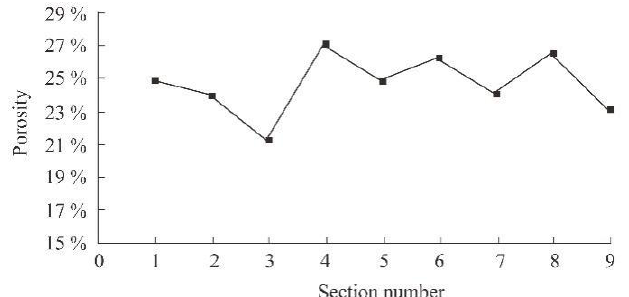
Figure 12. Distribution map of pore gradient with different diameters. ( a ) Distribution map of pore gradient in the range of 0.01–0.49 mm. ( b ) Distribution map of pore gradient in the range of 0.5–0.99 mm. ( c ) Distribution map of pore gradient in the range of 1–1.49 mm. ( d ) Distribution map of pore gradient in the range of 1.5–1.99 mm. ( e ) Distribution map of pore gradient more than 2 mm.